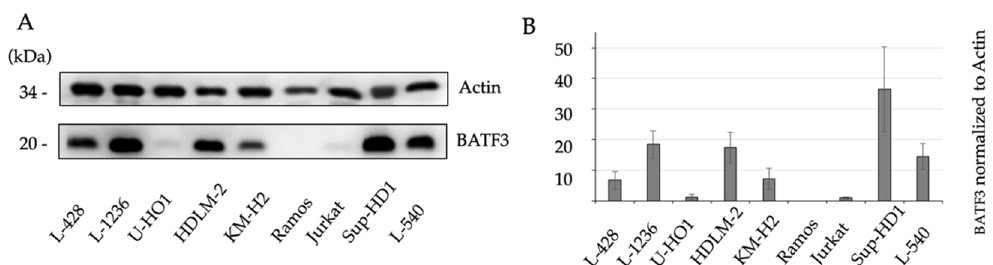
Figure 2. Truncated violin plots of BATF3-scores. Samples from CHL and ALCL showed constitu- tively high BATF3-scores, which could be clearly differentiated from those of the other lymphoma entities. An apparent threshold of 205 is indicated. Median ( — ) and Quartiles ( — ) are highlighted.